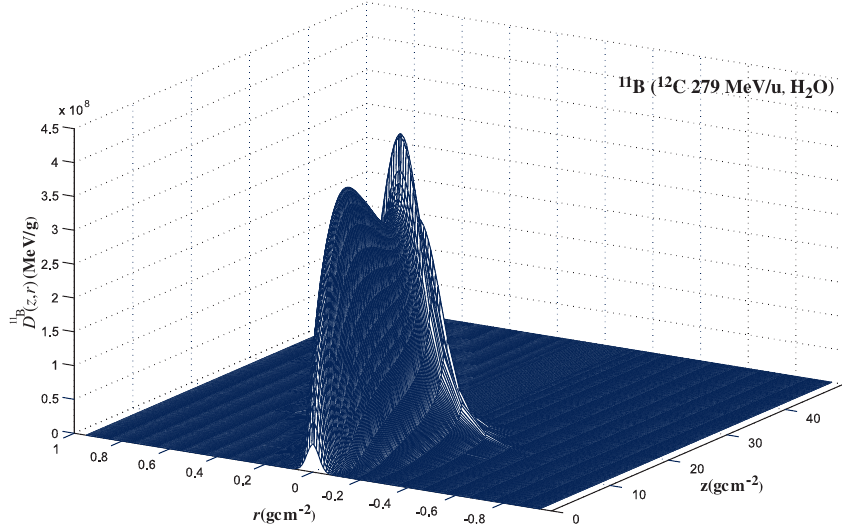
FIG. 7. The total analytical depth 3D absorbed dose variation [Eq. (43)] of secondary 11 B ions in a 0.6 mm diameter 12 C beam in water (solid curves). The absorbed dose of these heavy fragments is clearly influenced by rapidly increasing energy loss towards the end of their ranges, cf. Fig. 6. An accurate 3D description of the transport of the heavier fragments, such as 11 B and 11 C in the therapeutic 12 C beam, is of importance, since they help to accurately localize the high LET regions, where the greater variation in RBE are